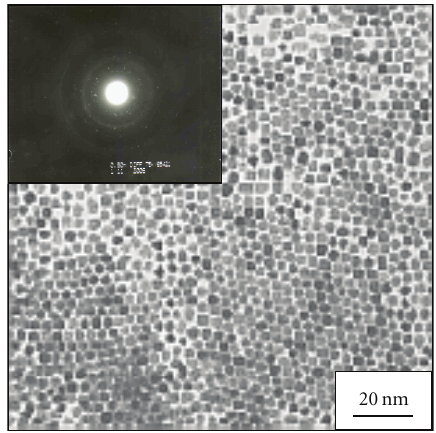
Figure 1: Transmission electron micrograph (TEM) with cor- responding electron di ff raction pattern with power condition at 300W.